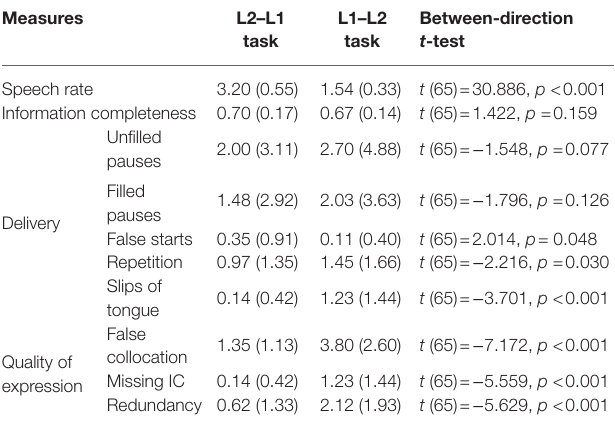
TABLE 6 | The distribution of passages. L2-L1 L1-L2